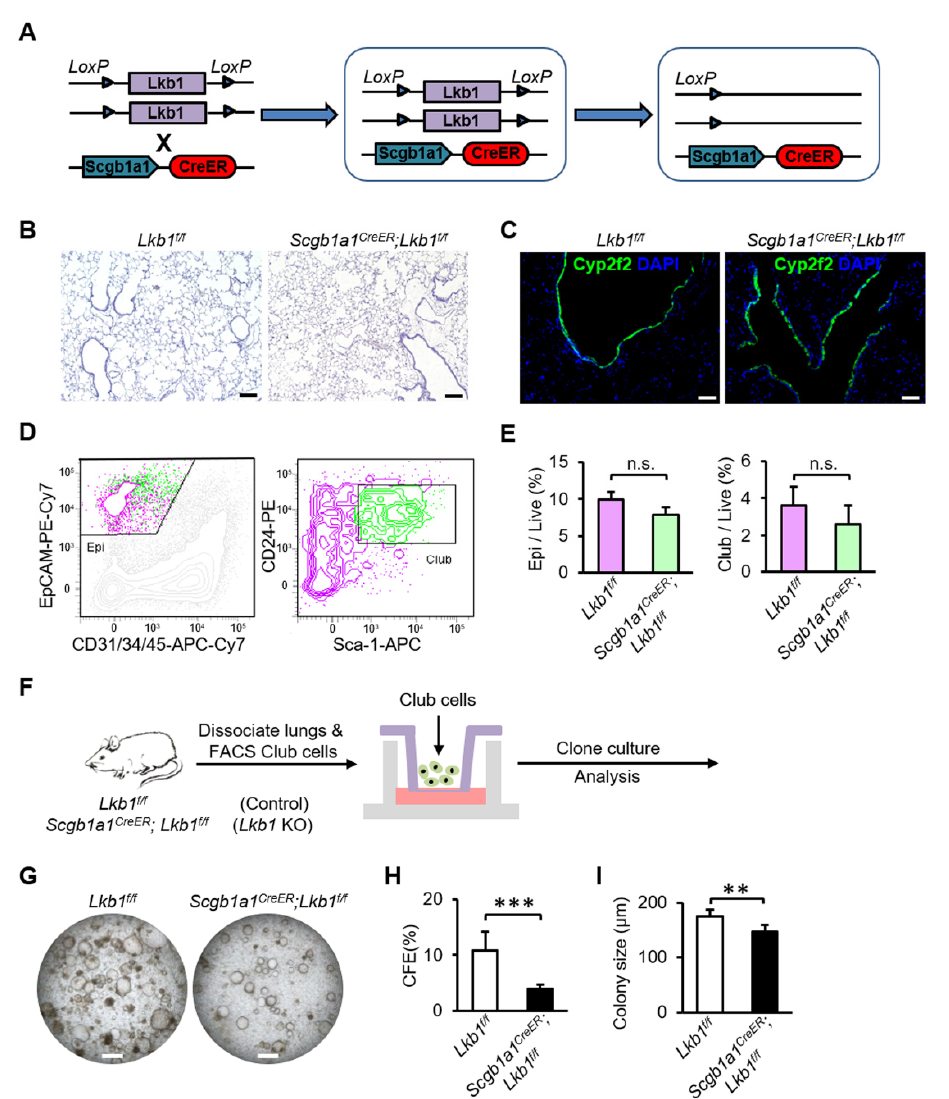
Figure 2. Lkb1 is required for the proliferation of airway progenitor cells in vitro. ( A ) Schematic of Scgb1a1 CreER ; Lkb1 f/f mice. ( B ) Hematoxylin and eosin staining of lung tissues from Lkb1 f/f mice and Scgb1a1 CreER ; Lkb1 f/f mice (Scale bars, 100 µ m). ( C ) Immunostaining of lung tissues for the detection of Cyp2f2 (Scale bars, 100 µ m). ( D , E ) Flow cytometry showed that there were no obvious differences in the fraction of epithelial cells and the abundance of club cells in the total live cell population between Scgb1a1 CreER ; Lkb1 f/f mice and Lkb1 f/f mice. ( F ) Schematic diagram of methods for cell isolation and organoid culture of club cells. ( G ) Representative micrographs of organoid cultures of club cells isolated from Lkb1 f/f mice and Scgb1a1 CreER ; Lkb1 f/f mice (Scale bars, 500 µ m). ( H , I ) CFEs ( H ) and colony size ( I ) of organoid cultures. Five independent experiments were conducted (n = 5). All data are presented as means ± SD, ** p < 0.01; *** p <